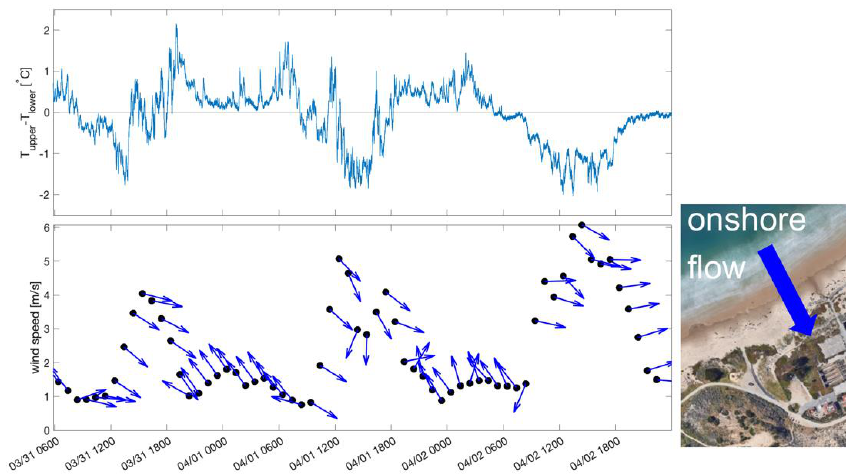
Figure 3. Periods of stable conditions (where the air temperature at the upper location was warmer than the lower location) were accompanied by offshore flow events. In the bottom diagram, the arrows correspond to the wind velocity direction. As show in the inset figure on the right, onshore flow occurs when the arrows point towards the lower right, whereas offshore flow occurs when the arrows point to the upper left.